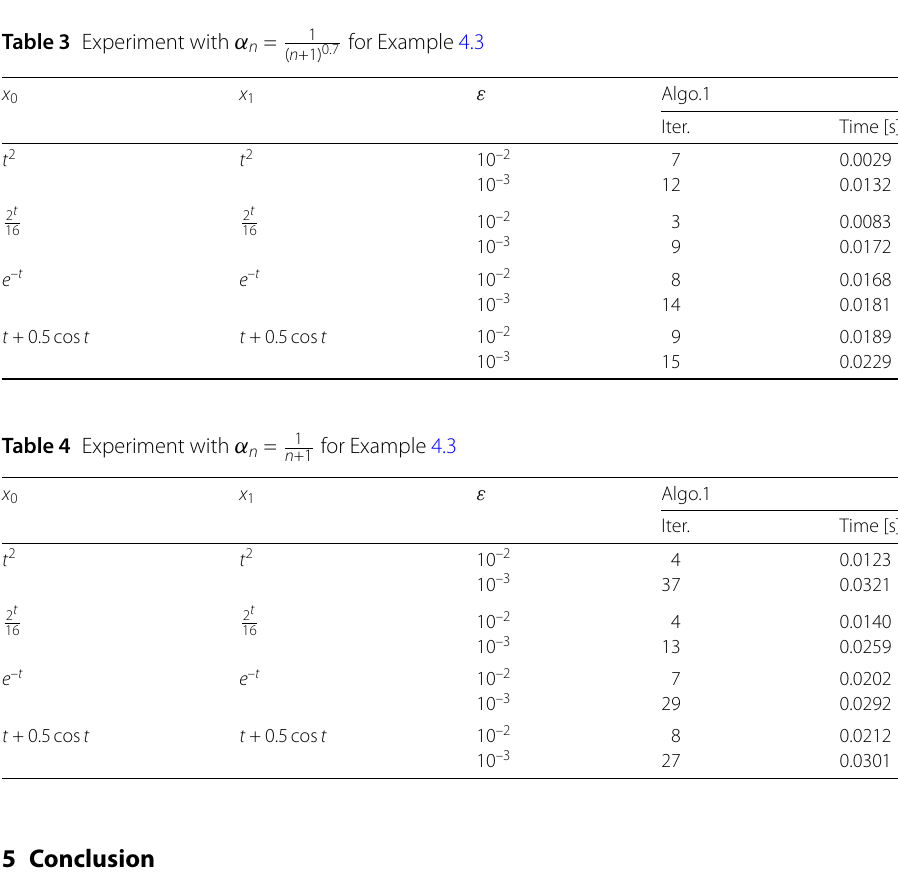
Table 3 Experiment with α n =